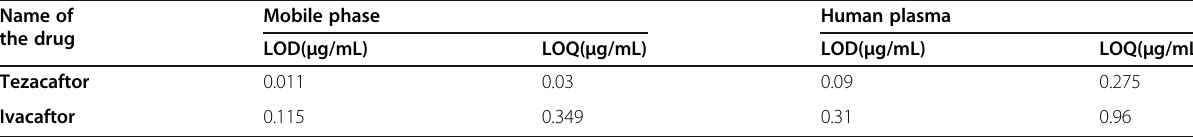
Table 11 LOD and LOQ study of Tezacaftor and Ivacaftor in mobile phase and human plasma Name of the drug